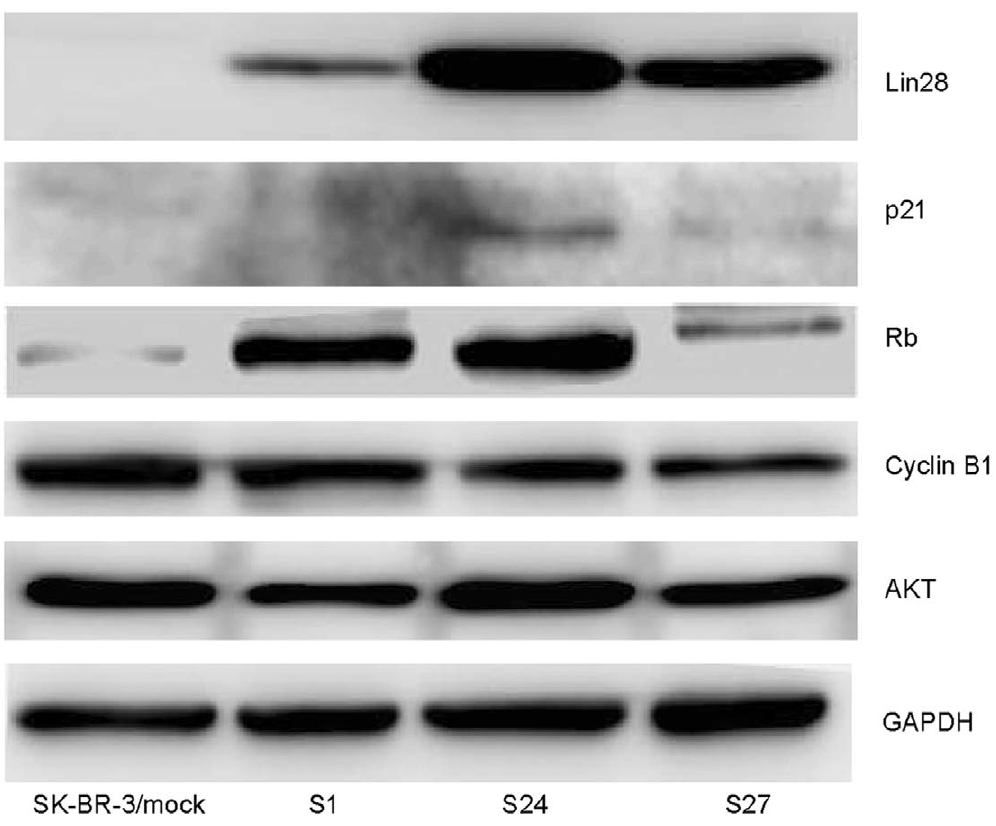
Figure 5. Lin28 regulates p21 and Rb expression. The expression of Lin28, p21, Rb, Cyclin B1 or Akt in SK-BR-3 cells stably expressing Lin28 was determined by Western blotting. The empty vector-transfected cells were used as controls. GAPDH was used as a loading control.